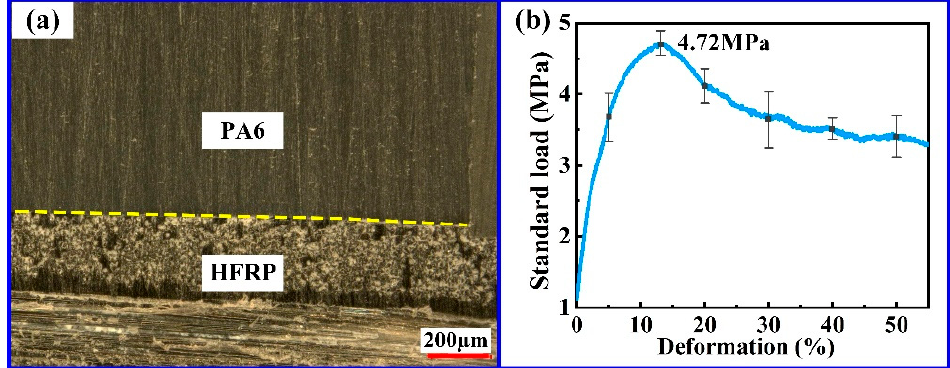
Figure 1. Composite parts: ( a ) cross-sectional profile; ( b ) tensile curve.